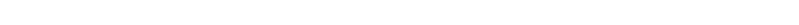
Fig. 7 TAK1 inhibition abrogates the SASP development and deprives cancer cells of stroma-conferred malignancy. a Heatmap pro fi ling of stromal cell transcriptomics after treatment by bleomycin alone, or together with each of 5Z-7, SB203580 (SB), and RAD001. Cells were collected 7d after drug treatment. The SASP-associated soluble factors are selectively displayed on the top list per expression fold change. b Transcript expression assay of several SASP canonical factors. Cells were treated by bleomycin alone or co-treated by bleomycin/SASP inhibitors. Signals were normalized to untreated samples per factor. Data analyzed by Student ’ s t -test. c GSEA pro fi ling with signi fi cant enrichment scores showing a SASP-speci fi c expression signature composed of canonical soluble factors. Head-to-head comparison of differentially expressed SASP factors was performed between cells treated by bleomycin only and cells co-treated by bleomycin/SASP inhibitors. P values determined by GSEA software. d The prostate cancer (PCa) cell line PC3 was subject to treatment by mitoxantrone (MIT) while being incubated with several types of conditioned media (CM). Upper, representative images of PC3 cells upon different treatments. Arrows, apoptotic cells; arrowheads, damaged cells. Scale bars, 50 μ m. Lower, viability assessment of several cell lines incubated with various types of CM and exposed to MIT at the IC50 concentration pre-determined per line. Data analyzed by Student ’ s t -test. e Measurement of apoptosis in culture conditions. Results were depicted in relative luminescence units (RLUs) representing signal readings proportional to caspase-3/7 activity of PC3 cells. Data analyzed by Student ’ s t -test. f Dose response curves (non-linear regression fi t) of PC3 cells treated by PSC27-derived CM. The concentration of MIT was plotted in an exponential scale, with cell viability assessed in relative to the untreated group and calculated in percentage. Data in all bar plots are shown as mean ±SD and representative of 3 biological replicates.* P < 0.05, ** P < 0.01, *** P < 0.001. BLEO bleomycin, SB SB203580, 5Z-7 5 Z